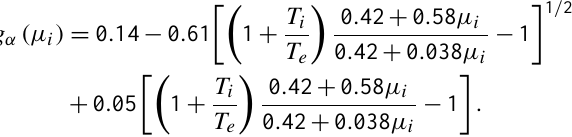
at 0.5 AU: T e = 1 . 5 × 10 5 K; n e = 1 . 2 cm − 3 ; B 0 = 5 . 3 nT or = 5 . 3 × 10 − 5 G. With such plasma parameters V 10 6 cm s − 1 , ω p i /(cid:127) i ∼ 3 × 10 3